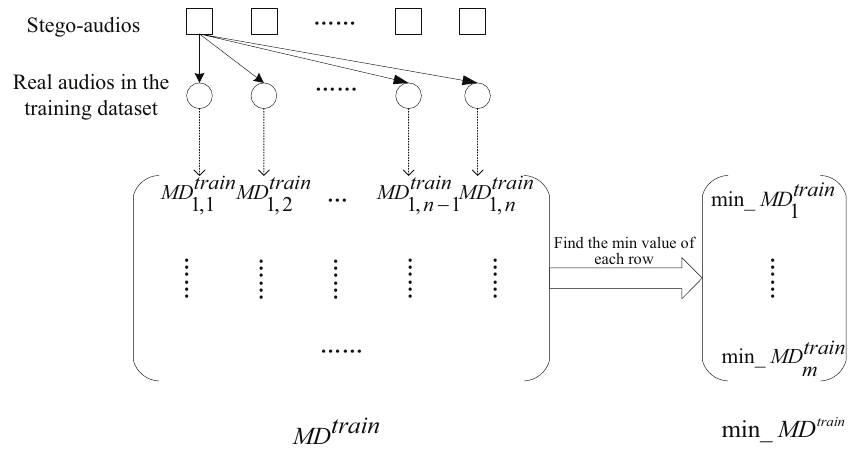
Figure 8. Illustration of Step